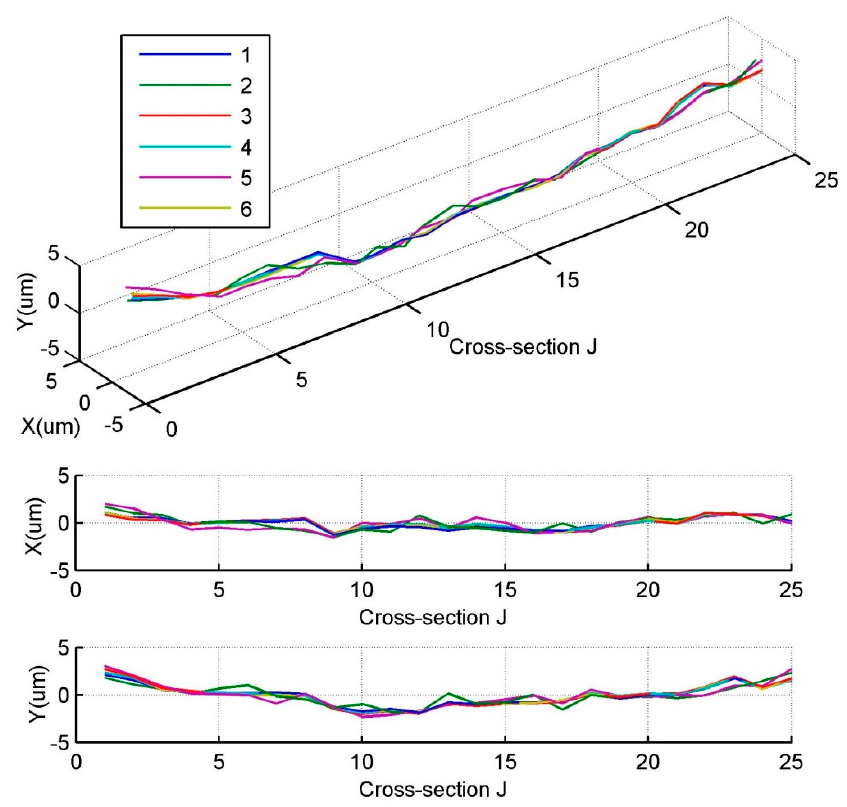
Figure 9. Median line profiles measured by the parallel four-point EST.